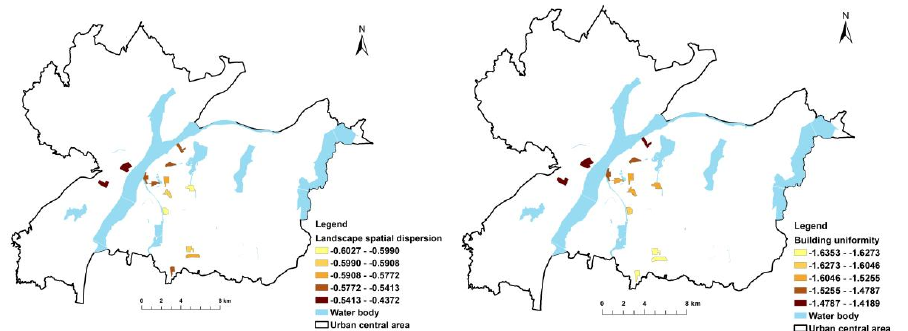
Figure 6. GWR results for commercial function zone.